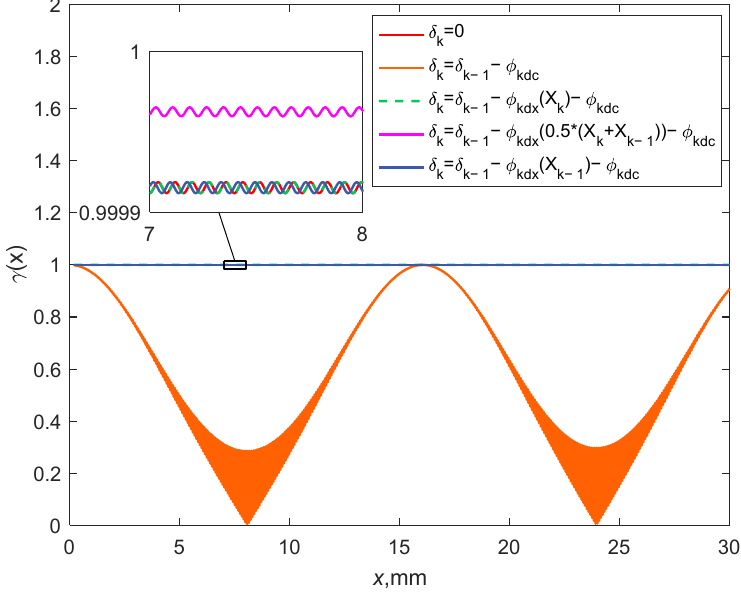
Figure 8. Exposure contrast under the condition of f k = g ( X k ) and S k = N steps / f k − 1 with different δ k .